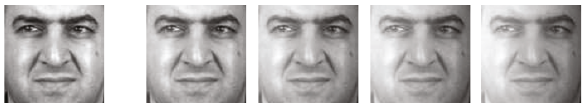
Figure 21: Examples of rendered face images (from left to right): the original face image, and the rendered image for τ = 40, the rendered image for τ = 80, the rendered image for τ = 120, the rendered image for τ =